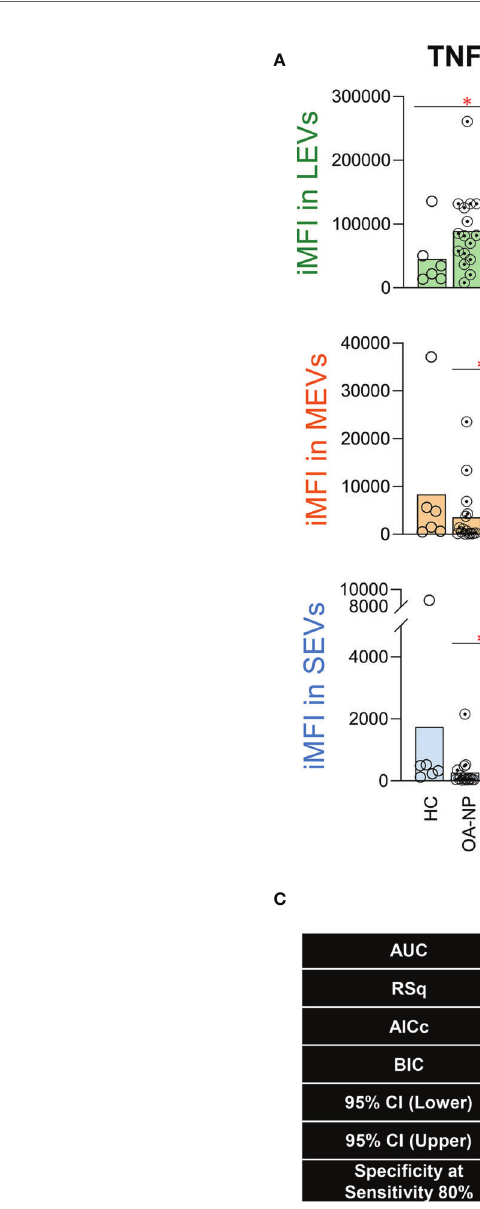
FIGURE 3 | The iMFI of endo-EV TNF- a at baseline was associated with knee rOA progression. Plasma EVs from HC (n = 6), OA-NP (n = 16) and OA-P (n = 14) participants at baseline were pro fi led for intra-vesicle TNF- a by high-resolution multicolor fl ow cytometry. (A) The graphs represent the iMFI of TNF- a in gated LEVs, MEVs and SEVs between HC, OA-NP and OA-P. Comparisons between HC, OA-NP and OA-P were performed using Kruskal-Wallis test with signi fi cant results de fi ned by FDR q< 0.05; asterisks indicate the p value as * <0.05 and ** <0.01. (B) Multivariable linear regression modeling was performed with adjustment for the baseline clinical variables to identify the associations of the knee OA radiographic severity changes from baseline to follow-up with the baseline iMFI of TNF- a in OA participants (n = 30, 53% OA-NP and 47% OA-P). The Leverage Plots represent plots of leverage of summed knee rOA progression (x axis) vs the baseline iMFI (y axis) of TNF- a in LEVs, MEVs and SEVs. (C) Multivariable logistic regression and ROC curve analysis were used to assess AUC and speci fi city (at sensitivity 80%) of TNF- a in LEVs, MEVs and SEVs in OA participants (n = 30, 53% OA-NP and 47% OA-P). Rsq, AICs, and BICs were based on likelihood ratio test. 95% bias- corrected CIs for AUCs are reported. LEVs, large EVs; MEVs, medium EVs; SEVs, small EVs; iMFI, integrated mean fl uorescence intensity. HC, healthy control obtained from Zenbio; OA-P, radiographic knee osteoarthritis progressor; OA-NP, radiographic knee osteoarthritis